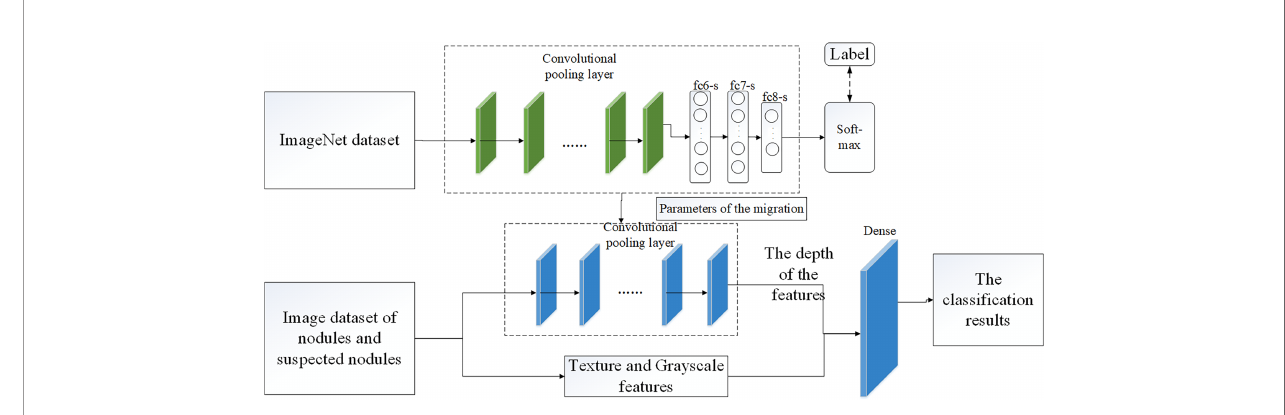
FIGURE 5 | Classi fi cation model of